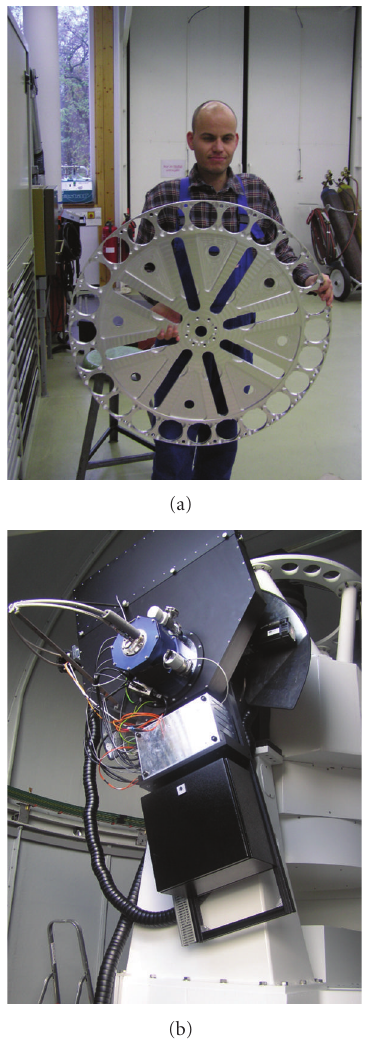
Figure 8: The Wide-Field STELLA Imaging Photometer